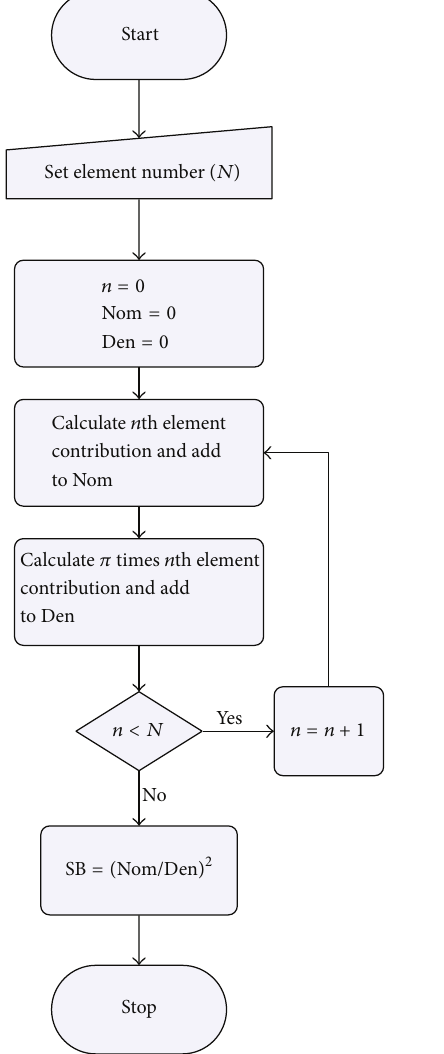
Figure 4: The illustrative flowchart of the SB method.